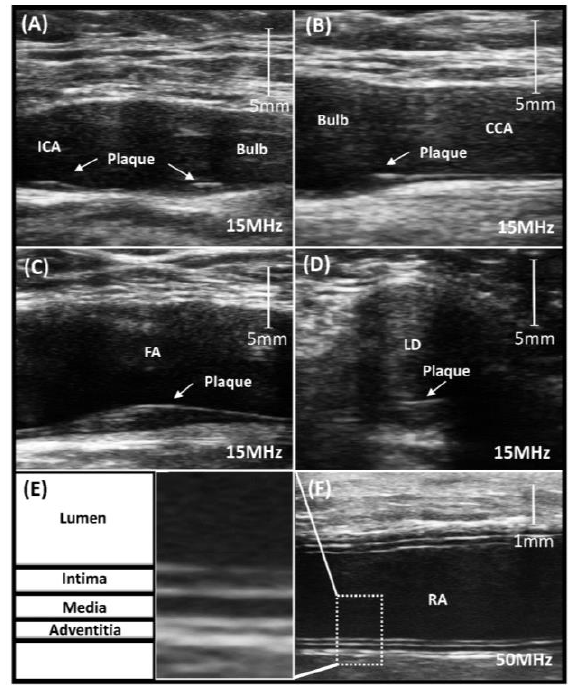
Figure 1. Ultrasound images of bulb and ICA ( A ), and proximal bulb ( B ) of a carotid artery with two plaques (15 MHz). Ultrasound images of a femoral artery with a large hypoechoic dorsal plaque in ( C ) longitudinal and ( D ) transverse imaging planes (15 MHz). Ultrasound image of a radial artery ( F ) with zoomed far wall ( E ) with diffuse intimal thickening seen as a four-line pattern (50 MHz). CCA, common carotid artery; FA, femoral artery; ICA, internal carotid artery; LD, Lumen. Unadjusted and adjusted vascular dimension data are presented in Table 2. HSCT survivors had smaller lumen diameters in radial and femoral arteries compared to controls and thicker IMT in carotid, brachial, and femoral arteries, with no consistent difference in adventitia thickness. The difference in LD disappeared in all arteries except for the femoral arteries when adjusting for age and BSA, whereas the difference in IMT between HSCT survivors and controls was exaggerated and statistically significant for all evaluated arteries, including the radial artery.